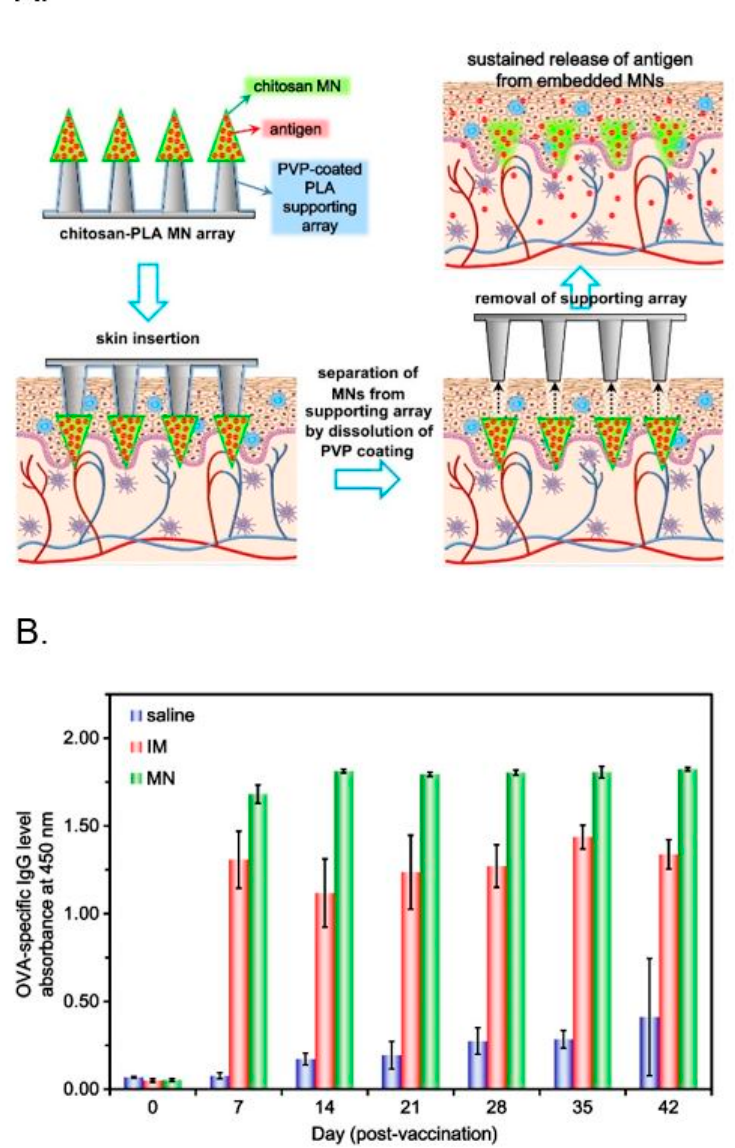
Figure 5. ( A ) Schematic illustrations of sustained transdermal delivery of antigen using a microneedle delivery system, composed of embeddable chitosan microneedles (MNs) and a poly( L -lactide-co- D , L -lactide) (PLA) supporting array. ( B ) OVA-specific IgG levels of rats after a single dose of antigen: non-immunized group (saline), intramuscularly immunized (IM, 1 mg OVA) and microneedle-immunized (MN, 1 mg OVA/array) rats (n = 3 for each group). (Reprinted with permission from Ref. [83]).